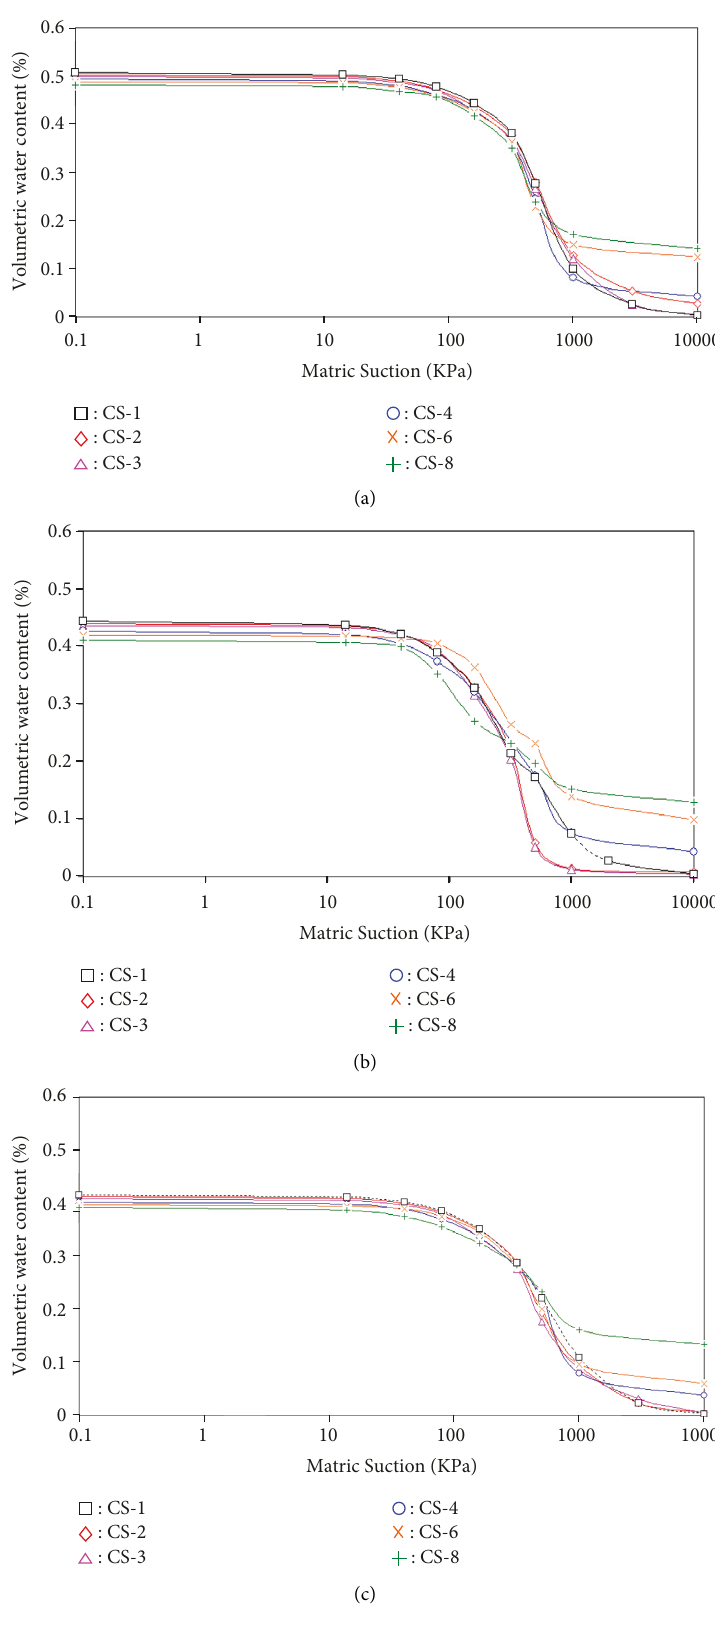
Figure 10: Sample SWRCs based on mix proportion and compaction condition: (a) loose, (b) normal, and (c)